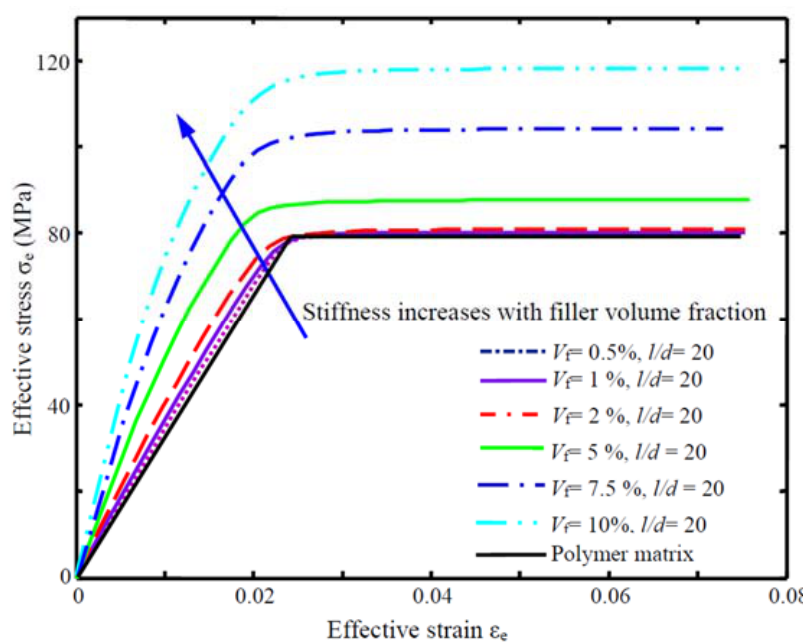
Figure 10. Effective stress-strain diagram σ e - ε e of the PNCs with the clay-particle aspect ratio ρ = 20 (plane-strain, case I).